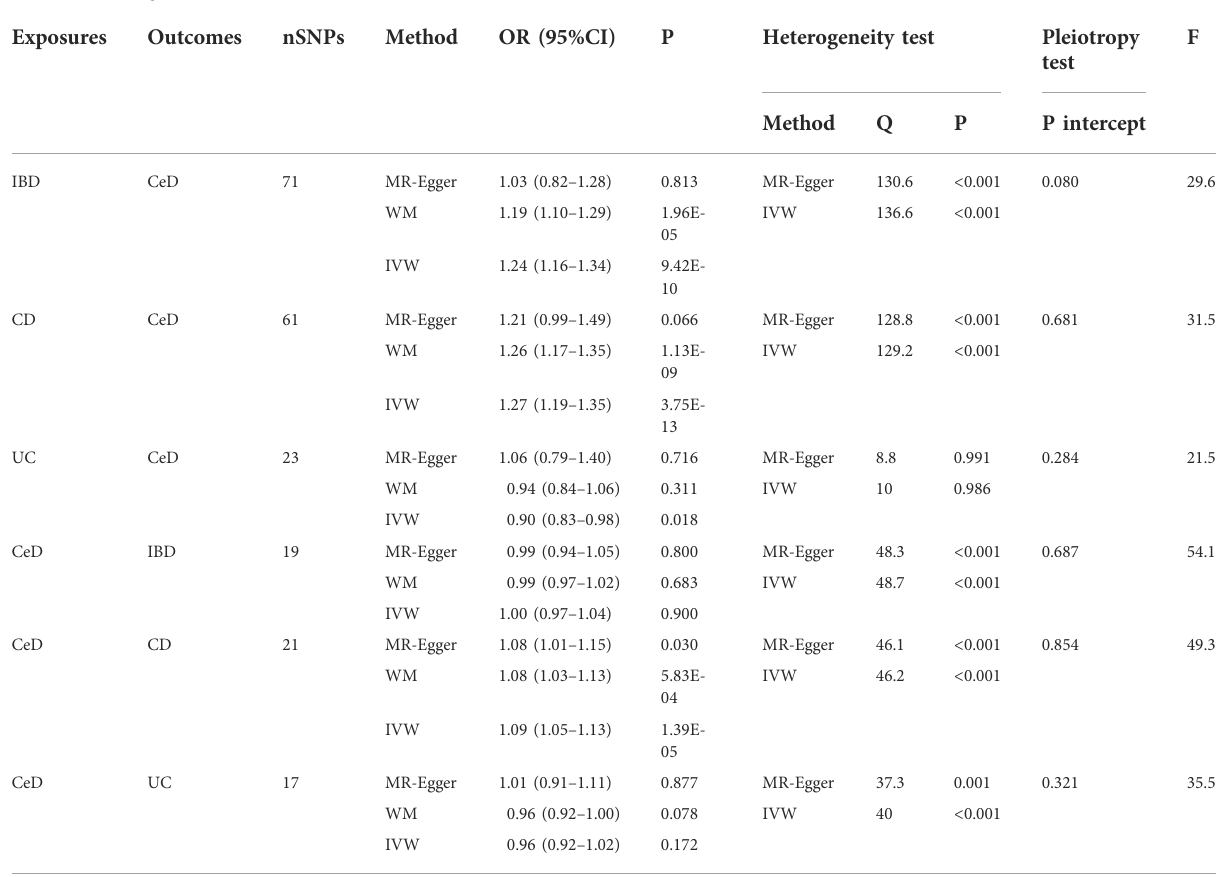
TABLE 1 MR analysis of the causal association between IBD and CeD.